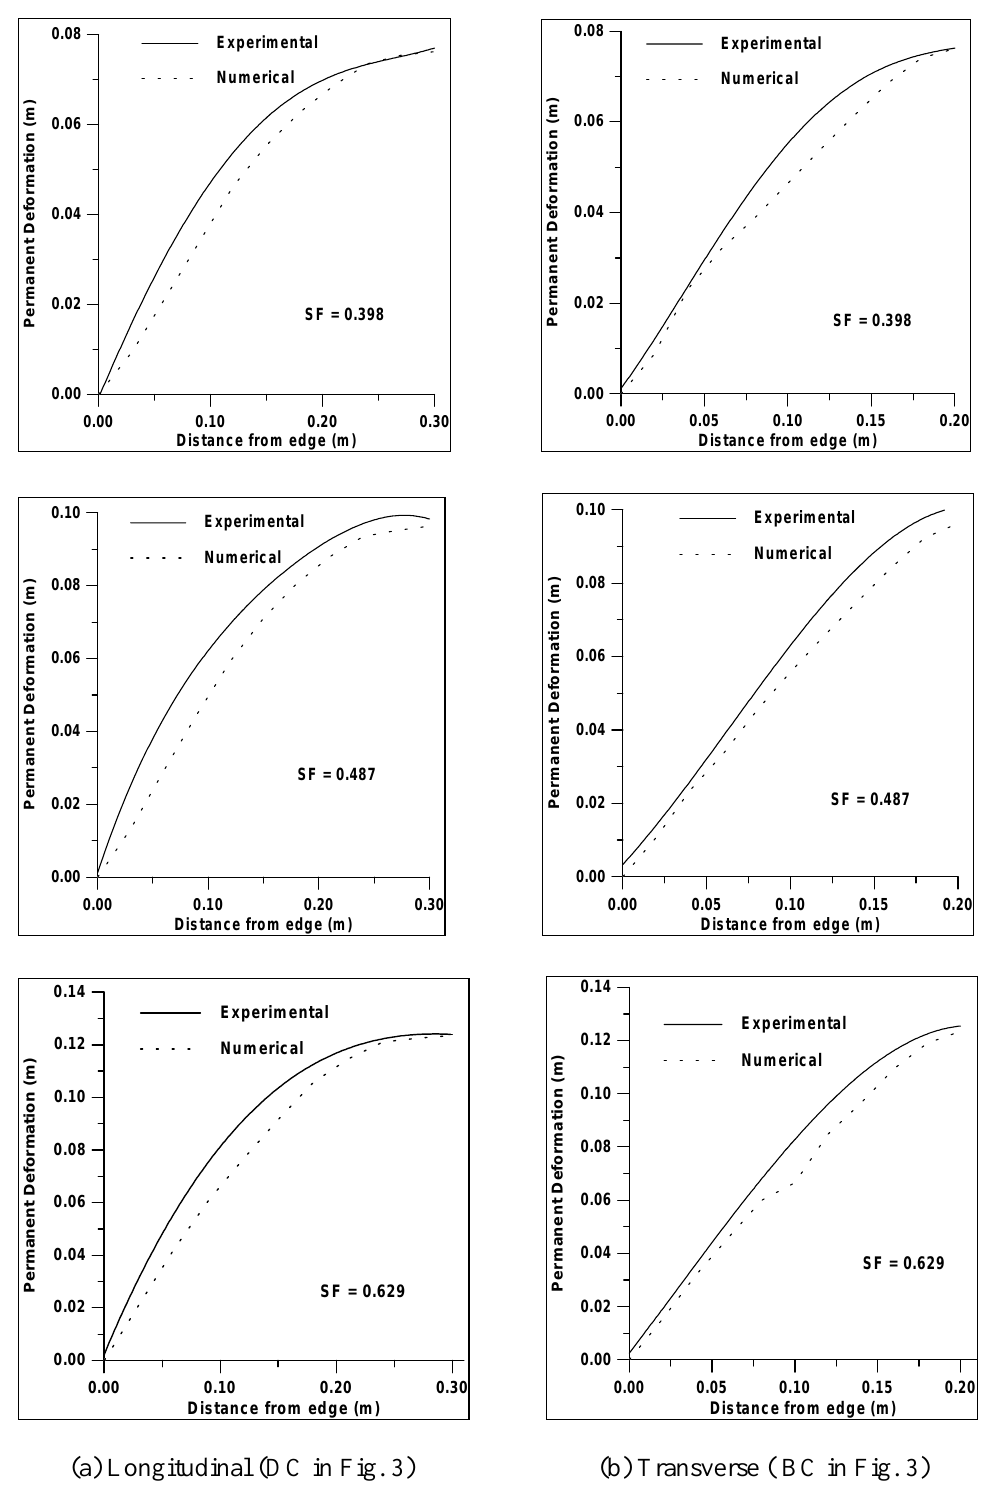
Fig. 16. Comparison of permanent deformation along center line ( h/l = 0 . 1